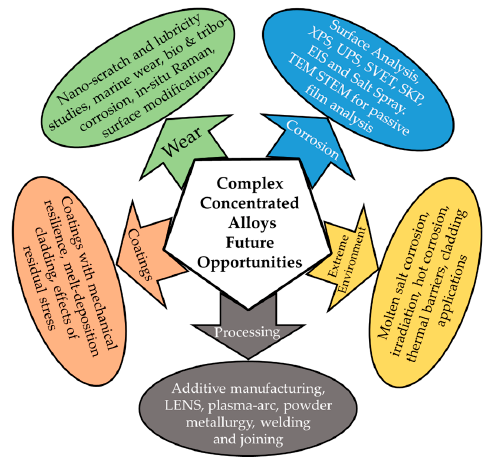
Figure 34. Future opportunities and outlook for complex concentrated alloys.